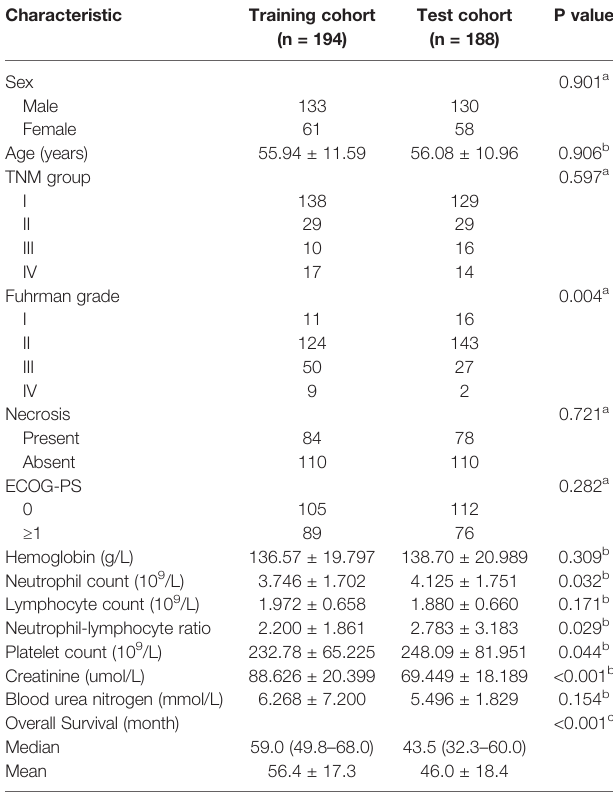
TABLE 1 | Baseline clinical date of the training and test